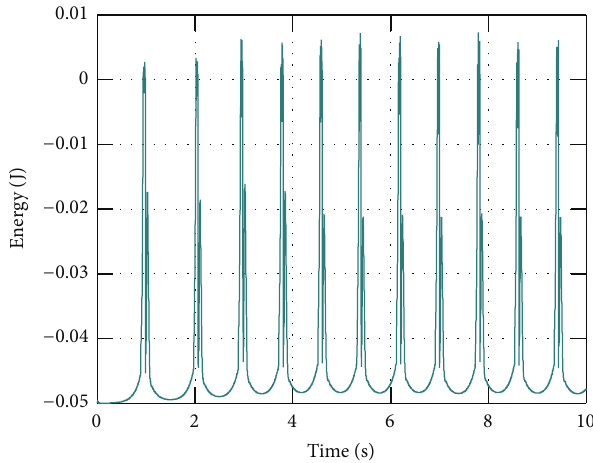
Figure 11: Error of energy. The joint torque values allow the error of energy to be more than 0, which means that the robot’s energy loss is compensated by the proposed